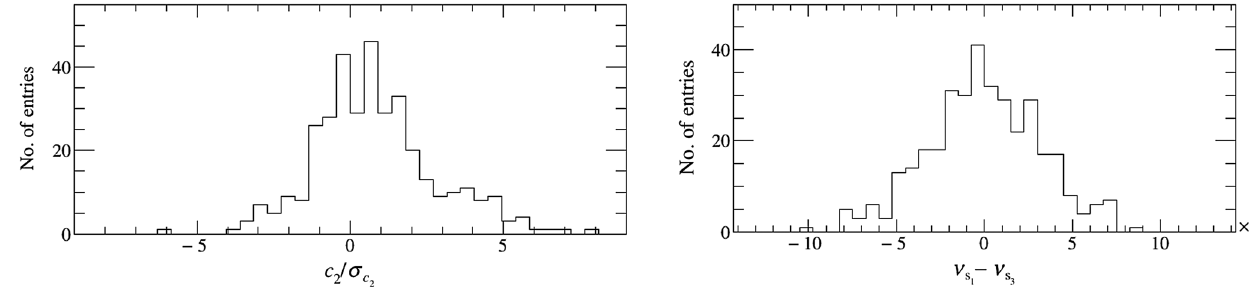
FIG. 15. Distribution of the difference of the baseline spin tunes , the ratio of the c 2 between time intervals Δ T 1 and Δ T 3 . The RMS value of this σ 0 . 8 (cid:3) 2 . 0 . distribution is used as an estimate of the systematic error of the c 2 ¼ spin tune jumps, yielding δ Δ ν syst s ¼ 3 . 23 × 10 − 9